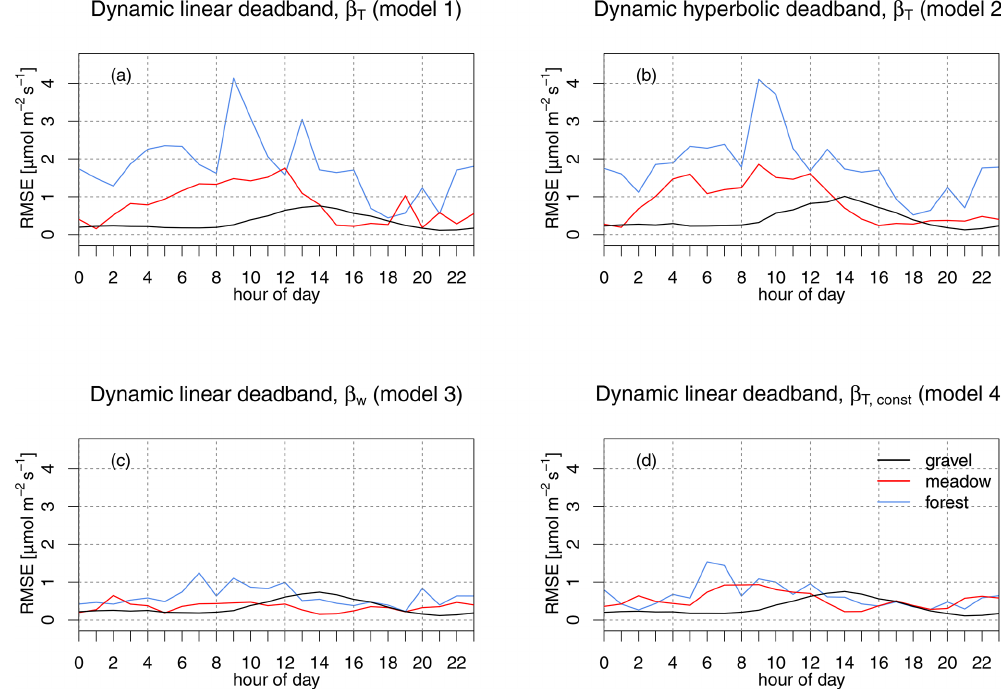
Figure A1. Same as Fig. 9 but for the CO 2 flux. The gravel site results (solid black lines) should be regarded with caution as the magnitude of the CO 2 flux at this site is close to zero (compare to Fig.